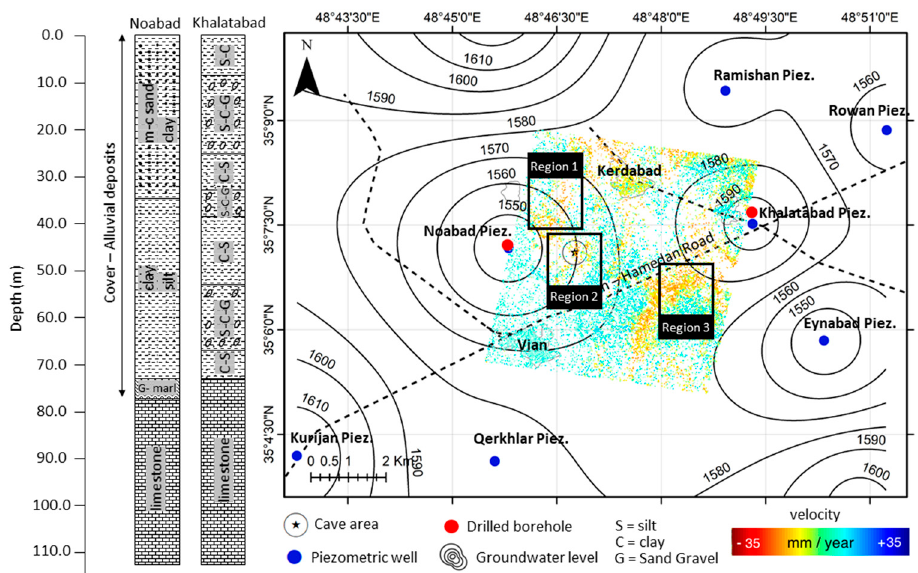
Table 3. Characteristics of three regions whose time-series behavior was analyzed.